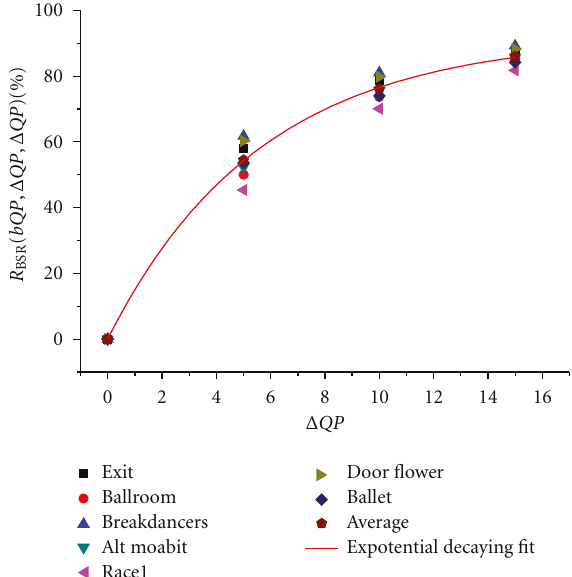
Figure 5: The relationship between R BSR (bQP, Δ QP, Δ QP) and Δ